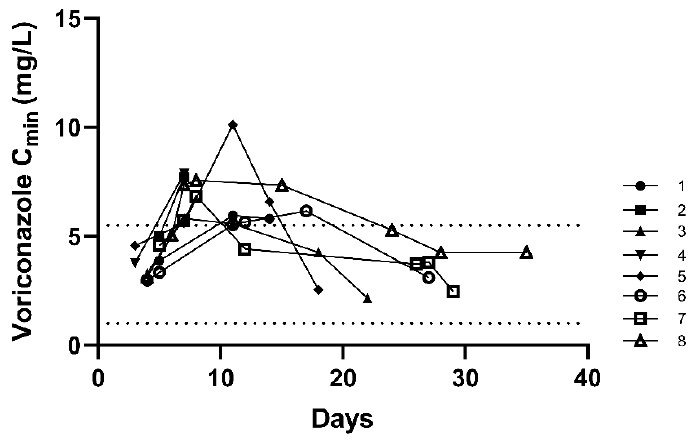
Figure 4. The voriconazole trough concentrations by days of 8 patients who had targeted C 0 but supratherapeutic C 1 during the constant unchanged therapy dosage of voriconazole ( n = 38).